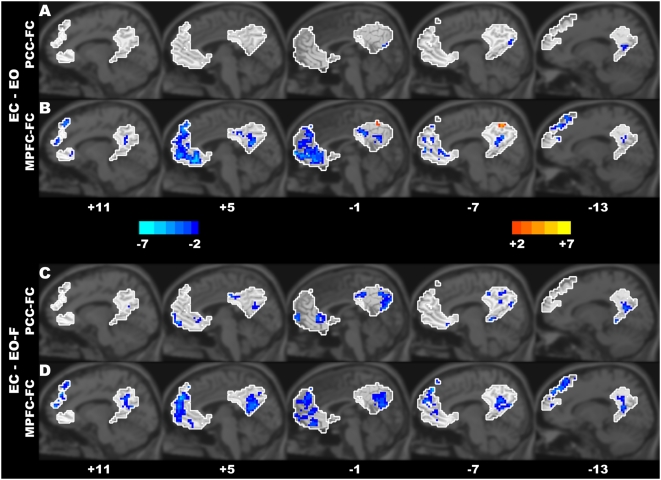
The between-condition differences of the functional connectivity within the DMN.Significant differences were found in the PCC-FC and the MPFC-FC maps between the EC and EO (A, B) and between the EC and EO-F (C, D) resting-state conditions. The areas in the white contours denote the ROIs within the DMN. The numbers below the images refer to the x coordinates in the Talairach and Tournoux space. The statistical threshold was set at |t|>2.093 (P<0.05) and cluster size >486 mm3, which corresponds to a corrected P<0.05.